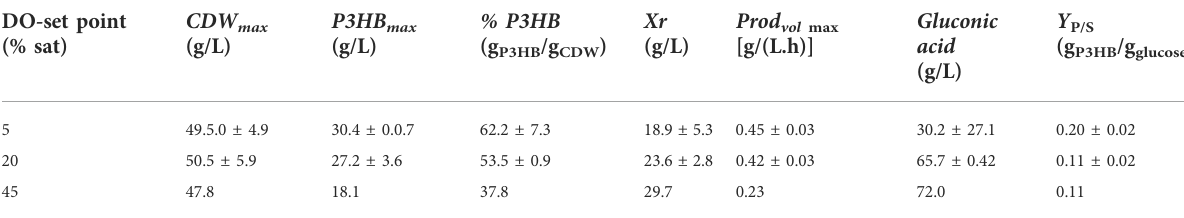
TABLE 3 Summary of the results obtained for H. boliviensis fed-batch cultivations in a bioreactor using P-lim conditions and different oxygen concentrations. DO-set point (%